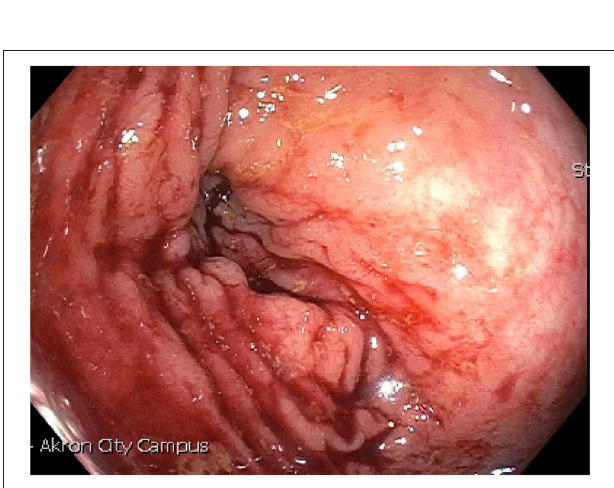
FIGURE 4 | Endoscopic evidence of narrowing due to external compression in sigmoid colon.